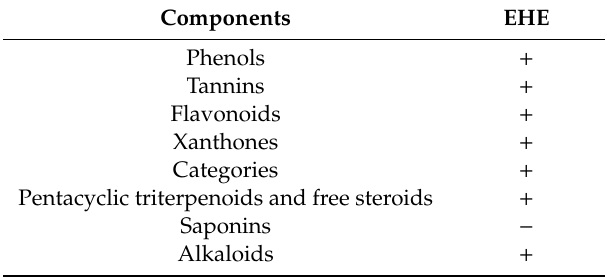
Table 1. Phytochemical prospecting of the hydroethanolic extract (EHE) of Bowdichia virgilioides . Components EHE Phenols + Tannins + Flavonoids + Xanthones + Categories + Pentacyclic triterpenoids and free steroids + Saponins − Alkaloids